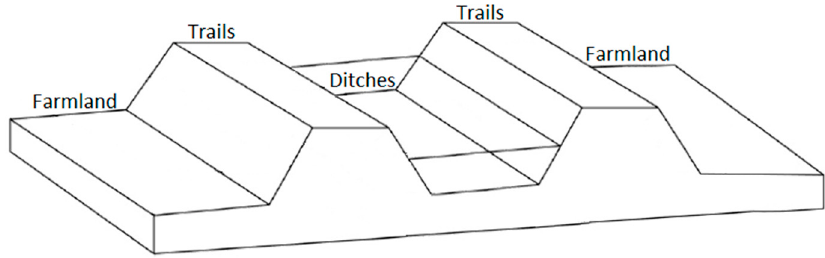
Figure 3. Ditch, trail, and farmland model.